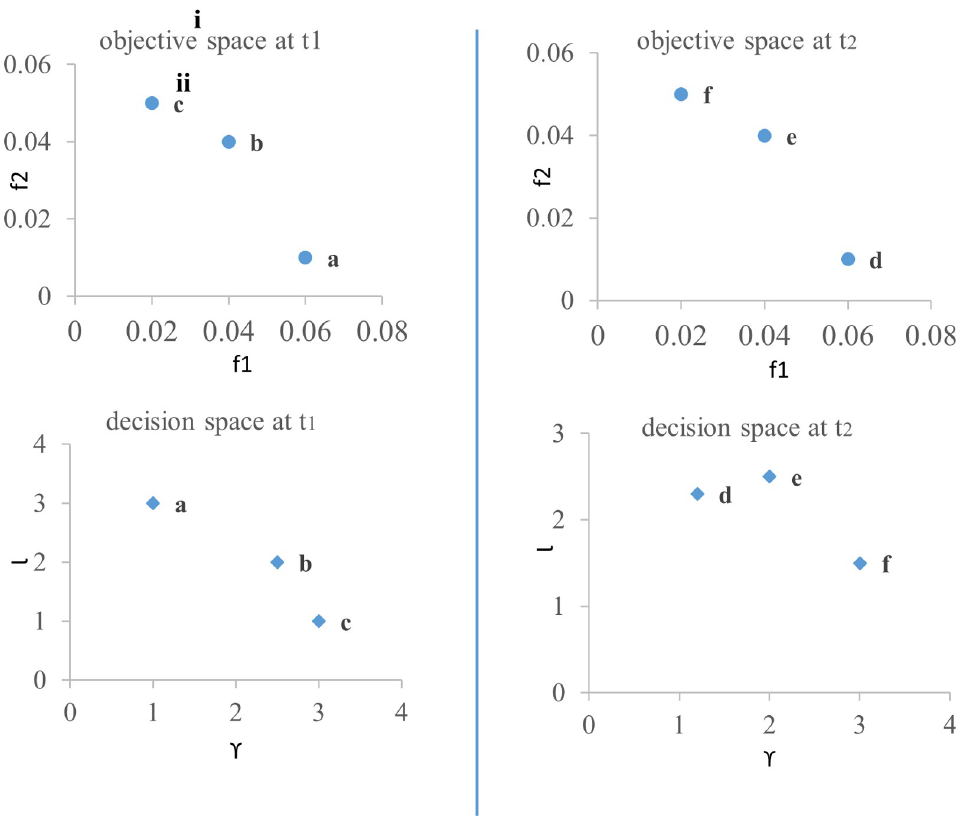
Fig 5. Illustration of non-dominated solutions. (i) Set of non-dominated solutions (upper panel) and the value of their corresponding decision variables (lower panel) at t1. (ii) Set of non-dominated solutions (upper panel) and the value of their corresponding decision variables (lower panel) at